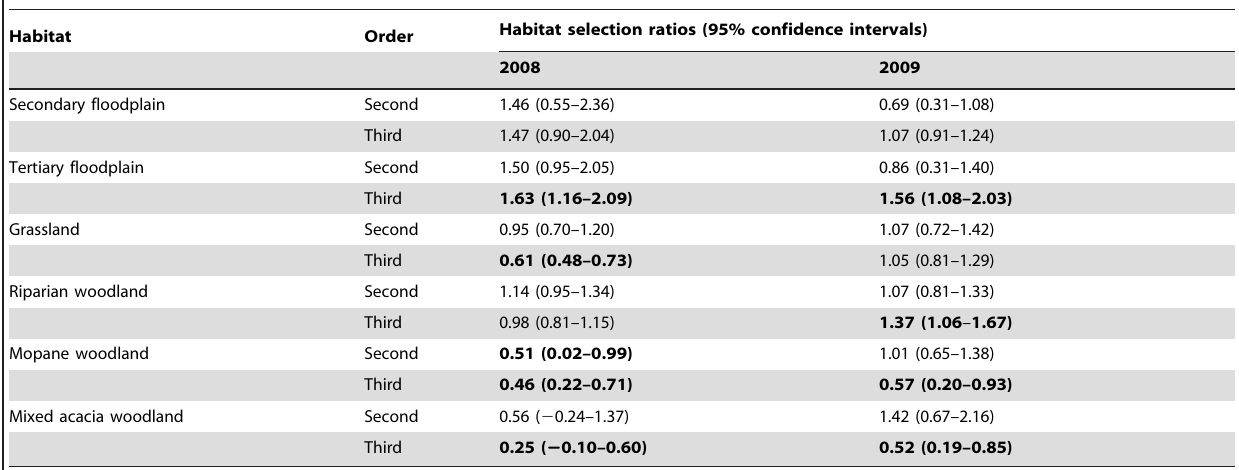
Table 6. Second and third order habitat selection ratios and confidence intervals during the late flood season in 2008 and 2009.